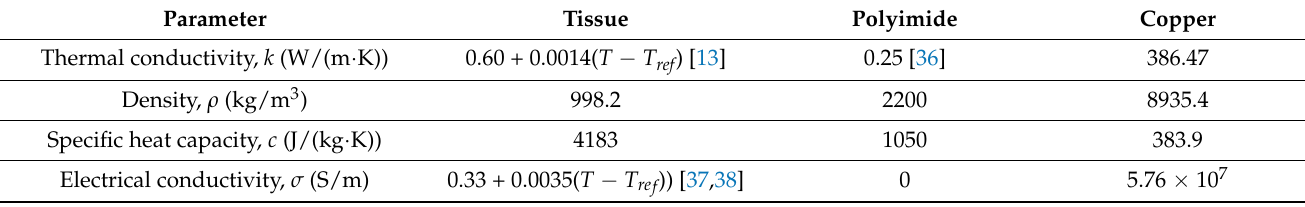
Table 1. The electrical and thermal parameters used in the